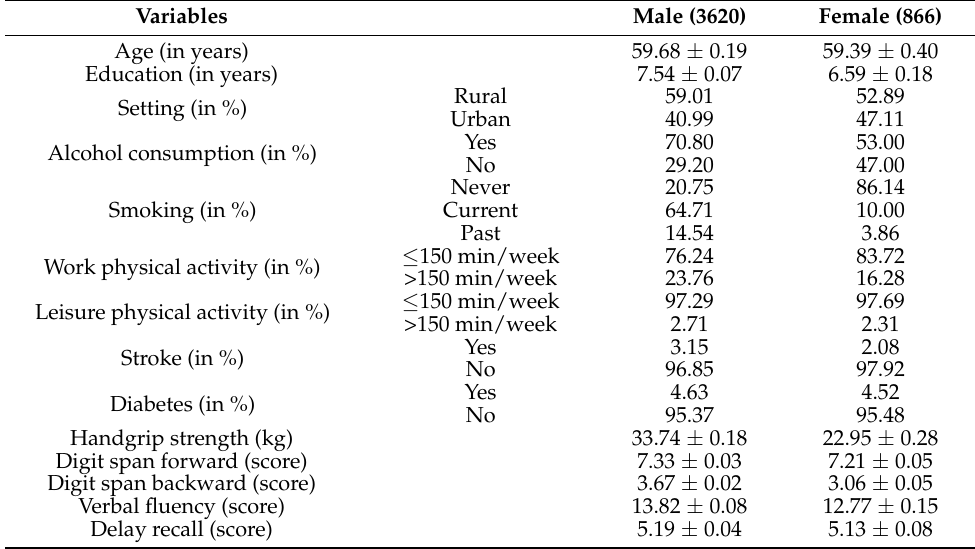
Table 1. Overview of demographic characteristics and measures of handgrip strength and cognitive